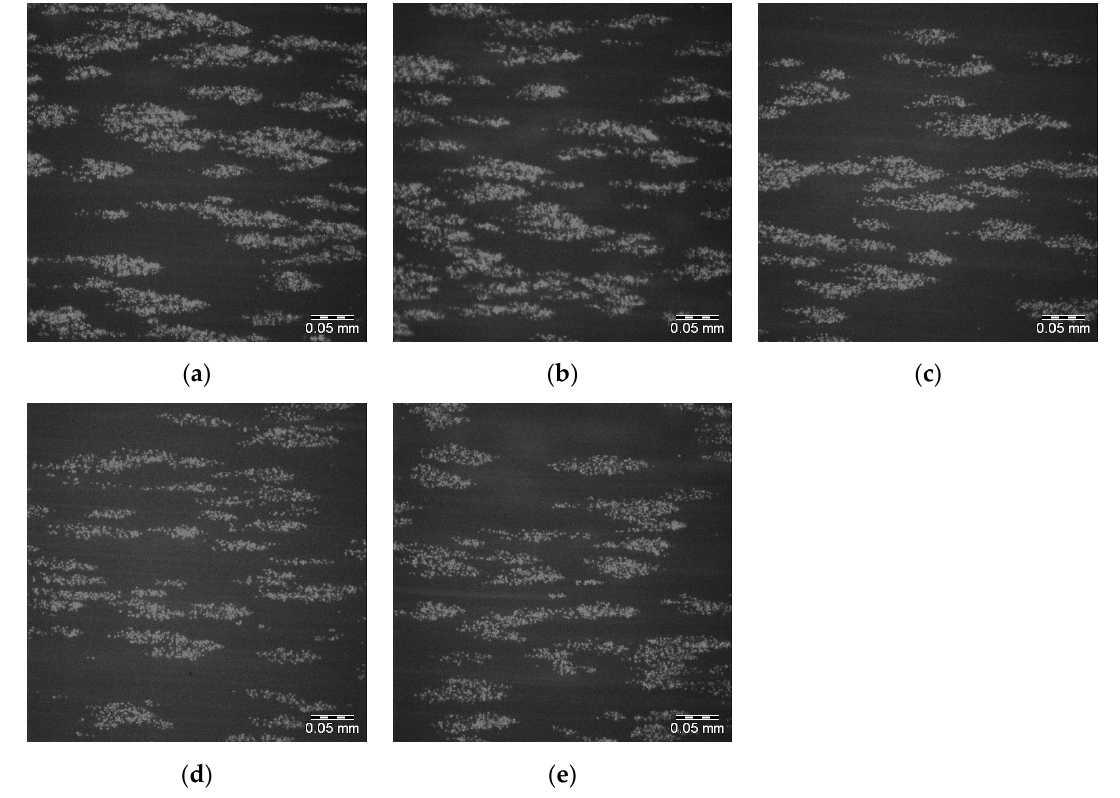
Figure 8. Fluoresence micrographs of whole blood DIOC 6 labelled platelets adhered to the surface of each of 5 replicates ( a – e ) of 25PS/75PMMA + 1500 polymer demixed surface. Scale bar 0.05 mm.